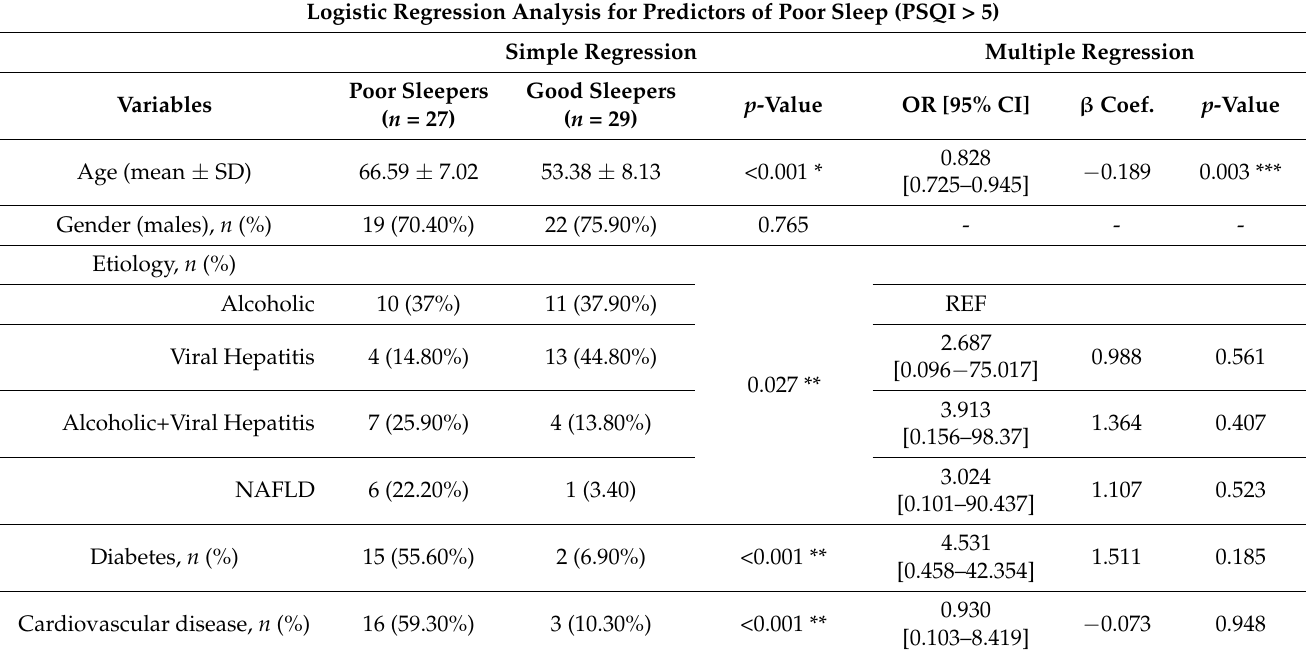
Table 4. Logistic regression analysis for predictors of poor sleep (PSQI >